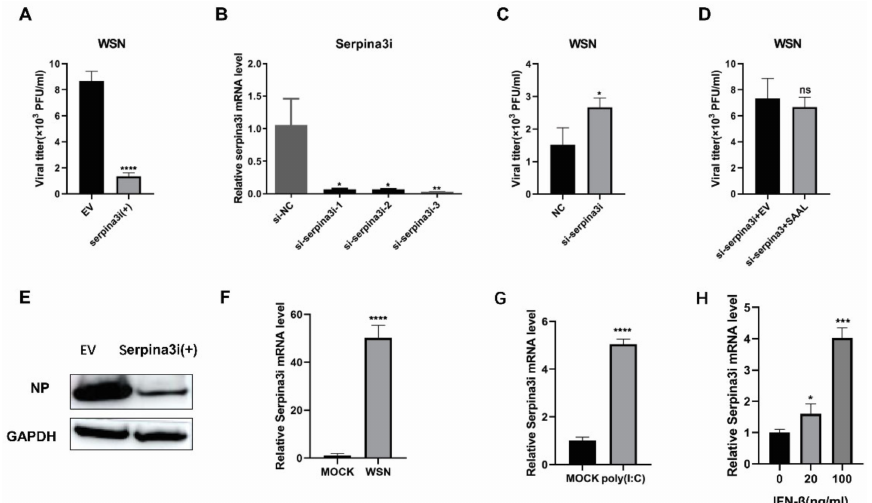
Figure 5. Serpina3i suppresses IAV regulation in Mle-12 cells. ( A ) Plaque assay evaluated the WSN replication after the overexpression of Serpina3i in Mle-12. The means for three independent experiments ± SD are shown ( n = 3; **** p < 0.0001). ( B ) The mRNA level of Serpina3i in Mle-12 cells after being transfected with siRNAs. The means for three independent experiments ± SD are shown ( n = 3; * p < 0.05; ** p < 0.01). ( C ) Plaque assay evaluated the WSN replication after the knockdown of Serpina3i in Mle-12. The means for three independent experiments ± SD are shown ( n = 3; * p < 0.05). ( D ) Mle-12 cells were transfected with si-Serpina3i for 24 h and then transfected with pcDNA3.1 or pcDNA-SAAL for 12 h. Viral titers in supernatants were measured at 24 hpi. ( E ) Western blotting evaluated the IAV replication after the overexpression of Serpina3i in Mle-12. ( F , G ) Mle-12 cells were stimulated with WSN and poly(I:C). Then. RT-qPCR was performed to determine the mRNA level of Serpina3i. ( H ) Mle-12 cells were stimulated with increasing amounts of IFN- β for 16 h. RT-qPCR was performed to determine the levels of Serpina3i. The means for three independent experiments ± SD are shown ( n = 3; * p < 0.05, *** p <